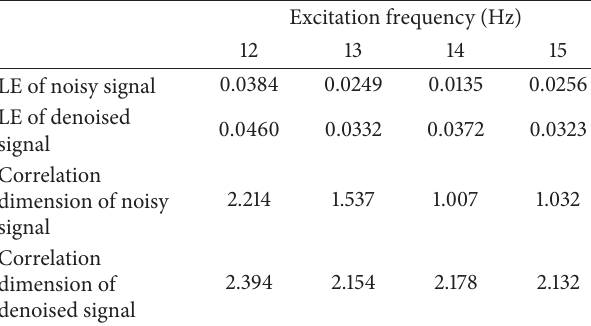
Table 4:Reconstructionparameters andcharacteristicexponents of measured